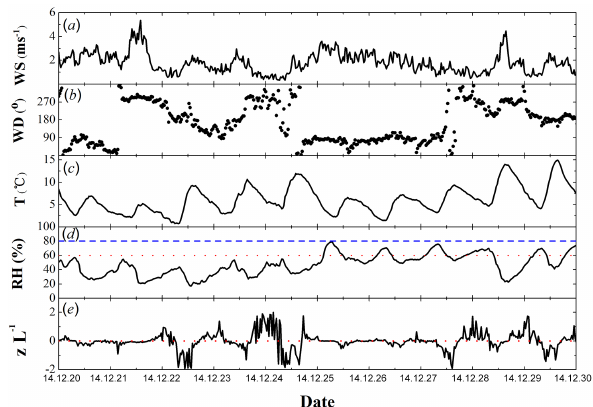
Figure 2. Temporal variations in the (a) wind speed, (b) wind direc- tion, (c) air temperature, (d) relative humidity (RH) and (e) dimen- sionless parameter ( z/L) observed during 20–29 December 2014. The dashed line in (c) denotes RH 80%, and the dotted line in (c) denotes RH 60%. The dotted line in (e) denotes z/L = 0. Details can be found in the